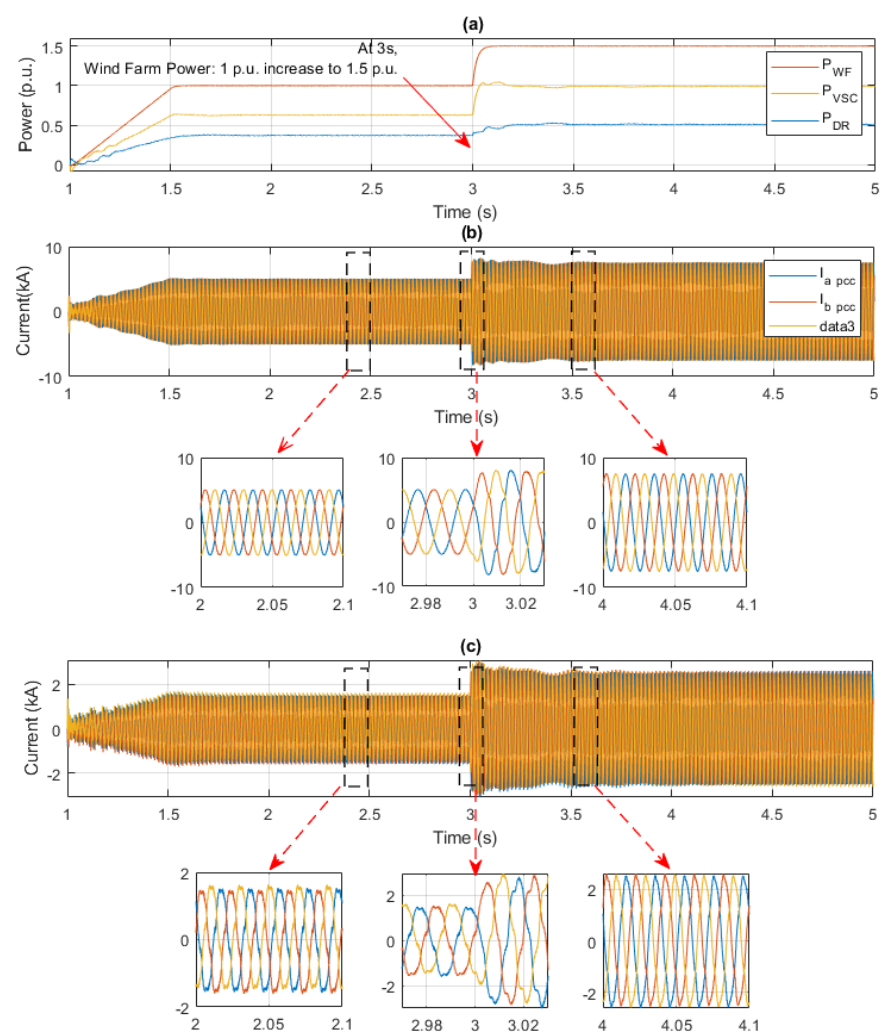
Figure 10. ( a ) Power flow through the different components of the offshore system. ( b ) The PCC current. ( c ) The current flowing through OF-VSC.